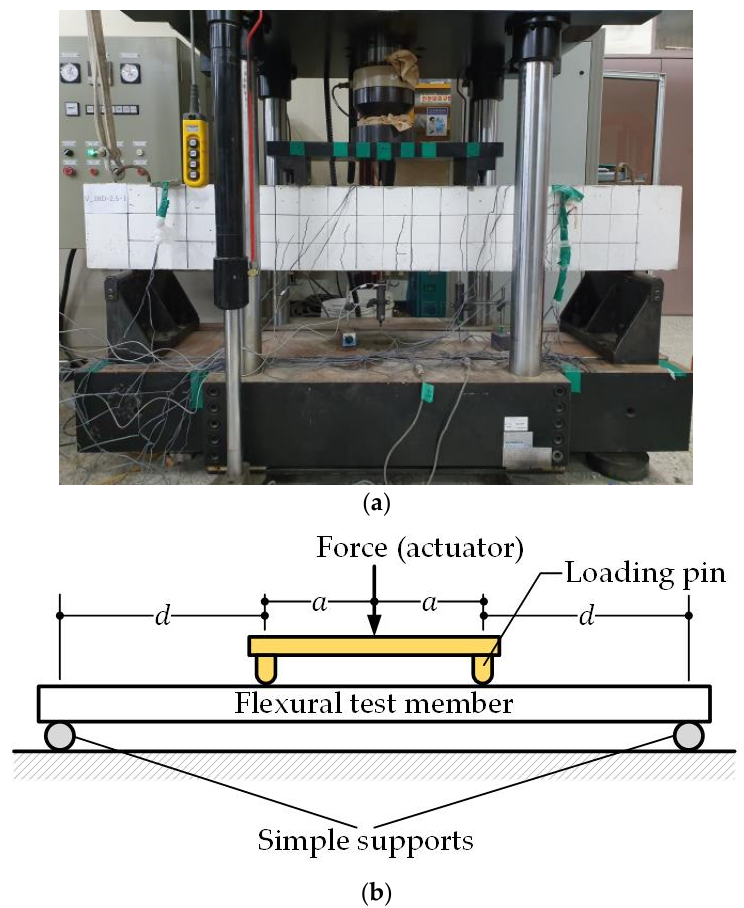
Figure 6. Four-point bending test of flexural members: ( a ) photograph of actual bending test; ( b ) schematic illustration.